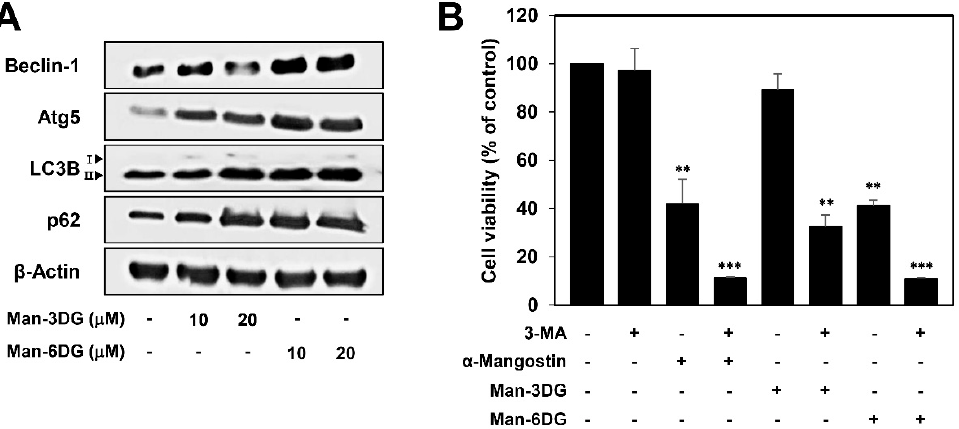
Figure 6. The e ff ects of α -mangostin glycosides on the autophagy of Hep3B cells. ( A ) The e ff ects of Man-3DG and Man-6DG on the expression of autophagy-related proteins in Hep3B cells. The cells were treated with Man-3DG and Man-6DG (10 and 20 µ M) for 24 h, and the protein levels were detected through western blot analysis using specific antibodies. The levels of β -actin were used as an internal control. ( B ) The e ff ects of α -mangostin, Man-3DG, and Man-6DG on Hep3B cell viability in combination with an autophagy inhibitor. Hep3B cells were treated with the three compounds (20 µ M) in the presence or absence of 3-MA (1 mM) for 24 h. The cell viability was measured through MTT assay. Each value represents the mean ± SD from three independent experiments. ** p < 0.01 and *** p < 0.001 versus the